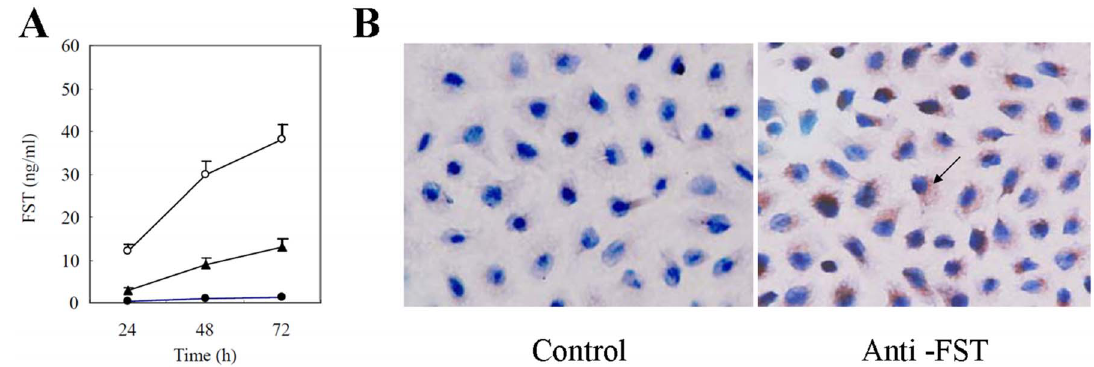
Figure 3. The production of FST from lung adenocarcinoma cells. (A) The tumor cells were incubated in 2.5% and 10% FCS-IMEM culture medium, respectively. The non-tumor lung tissue cells were incubated in 10% FCS-IMEM culture medium. The supernatants of cultured cells were N harvested at the indicated time point and FST levels were detected by ELISA. # Lung adenocarcinoma cells with 10% FCS-IMDM medium. D Lung Non-tumor lung tissue cells with 10% FCS-IMEM medium. (B) FST protein expression in human adenocarcinoma cells with 2.5% FCS-IMDM medium. lung adenocarcinoma cell line A549 cells was examined by immunocytochemical staining with anti-FST antibody (Anti-FST). A procedural background control (Control) was performed using normal mouse IgG instead of anti-FST antibody.